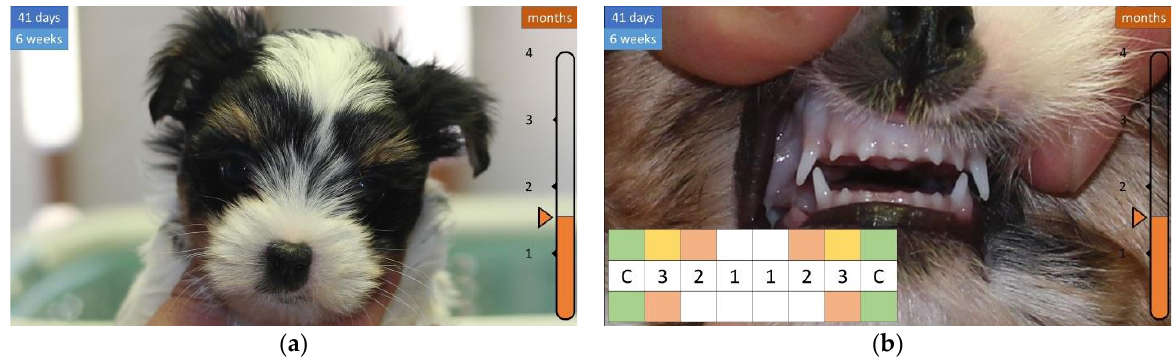
Figure 5. Development of the coat and teeth in a 6-week-old puppy. ( a ) Even longer coat. ( b ) Visible canines and new incisors.